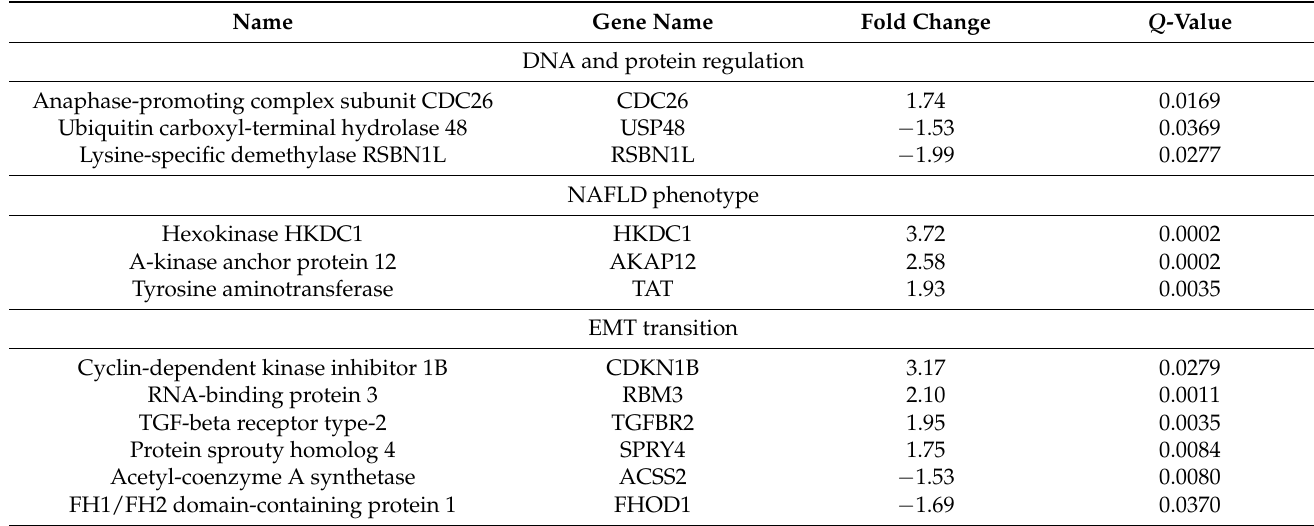
Table 2. Proteins significantly regulated in spheroids treated with 45 µ M palmitic acid and 65 µ M oleic acid compared to control grown in standard growth media after 7 days of treatment. Statistical analysis was performed using PolyStest ( p < 0.05, n =